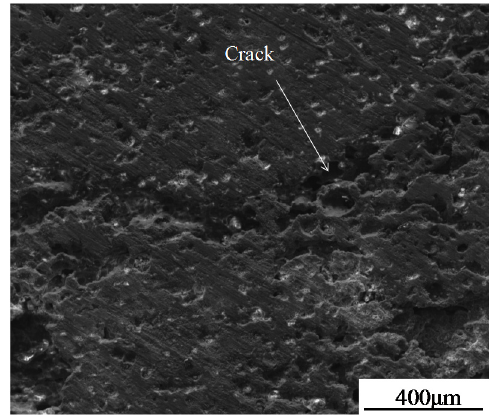
Figure 12. Thermal fatigue crack on the surface of the original coating. Coatings 2017 , 7 , 203